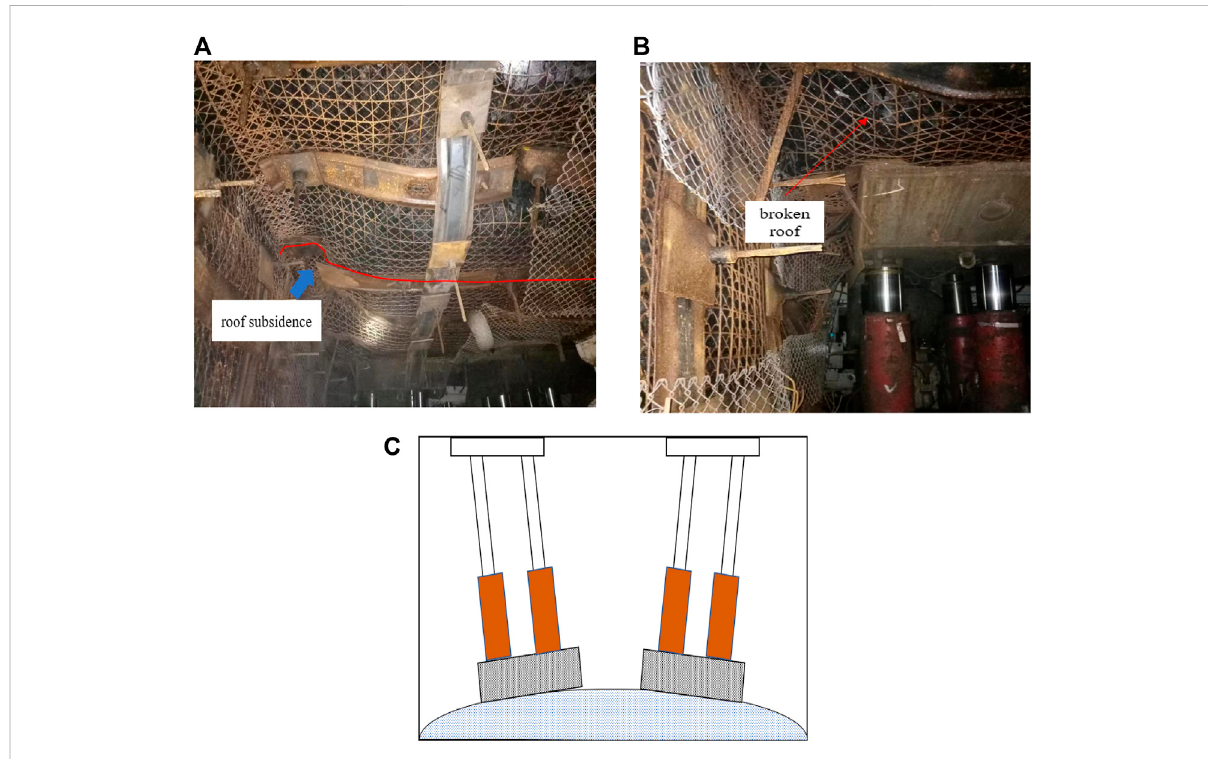
FIGURE 12 Problems faced by the Lijiahao advance support. (A) Roof deformation. (B) Broken roof. (C) Hydraulic support